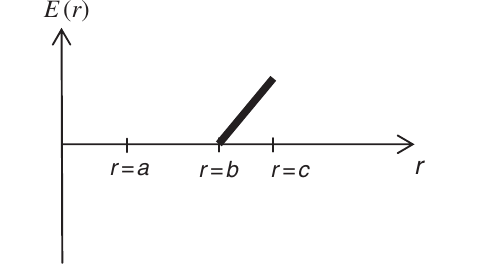
FIG. 3. Reproduction of a plot by a student in region b < r < c . His plots in other regions have been excluded for